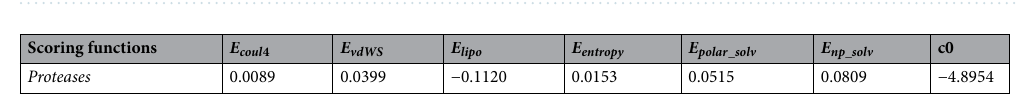
Table 3. Coefficients of the terms obtained for the protease-specific scoring functions trained with MLR.